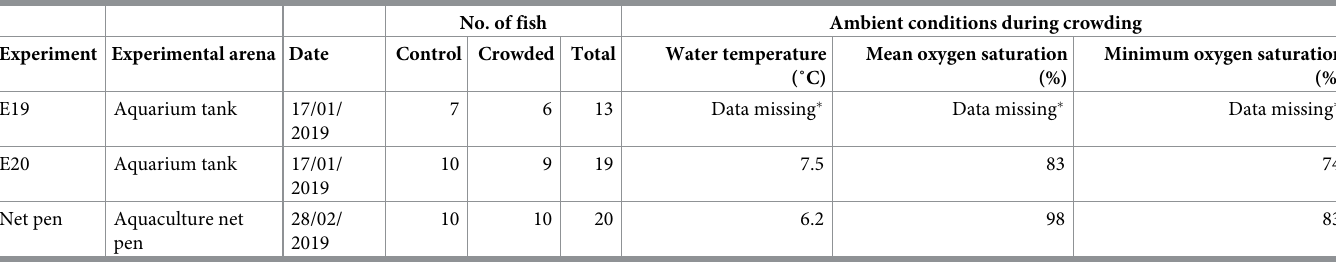
Table 1. Experimental design. Detail of the different experiments and associated sample sizes used to assess physiological and flesh quality responses of mackerel exposed to